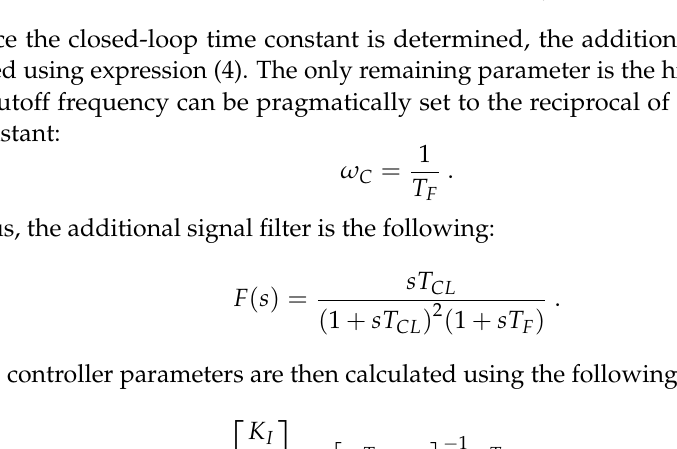
Figure 7. Filtering of input ( u ) and output ( y ) signals to obtain additionally filtered regression signals e F , i F and y F , where r = K PR u. The signal vector u F contains the measured values of the filtered signal u :